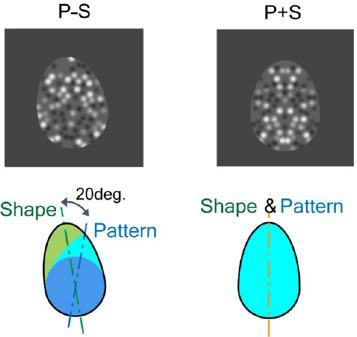
Figure 3. Left: An example of incongruent, antagonistic stimuli (P–S stimulus) in which the axes for SP and SS are tilted in opposite directions. The dot pattern is mirror symmetric with respect to the axis of SP, which is 10° (clockwise from the vertical) in this example. The egg-shaped contour of the P–S stimulus is also mirror symmetric with respect to the axis of SS, which is − 10° in this example. Right: An example of congruent, synergic stimuli (P + S stimulus) in which the axes for SP and SS are tilted in the same direction (the vertical in this example). The stimulus was generated in the same way as P–S stimuli except for the tilt of the symmetry